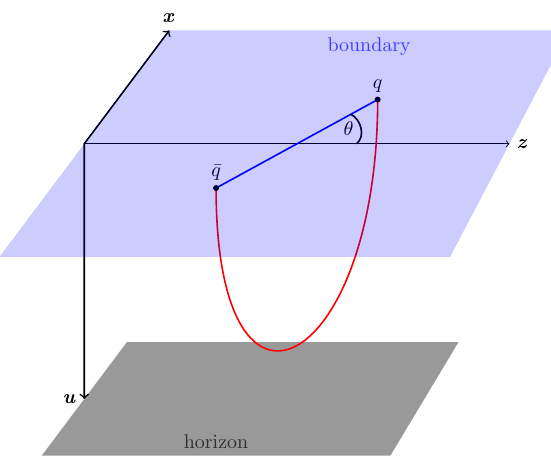
Figure 6 . Schematic picture of the string con(cid:12)guration that describes a q (cid:22) q -pair in the anisotropic theory. The connecting line has the angle (cid:18) to the anisotropic direction z